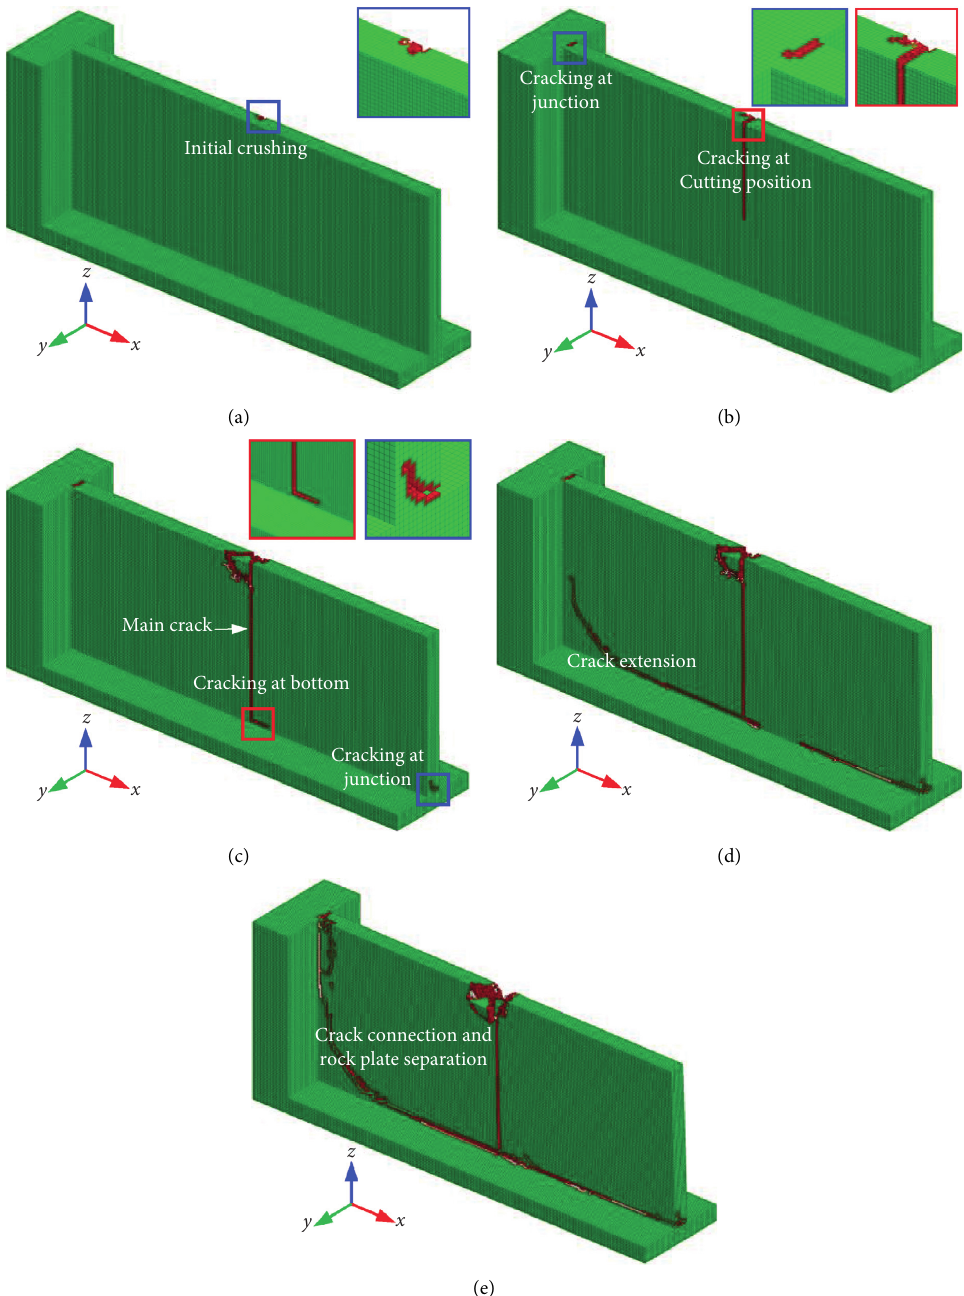
Figure 11: Rock plate cutting process. (a) Initial crushing. (b) Crack generation. (c, d) Crack extension. (e) Crack